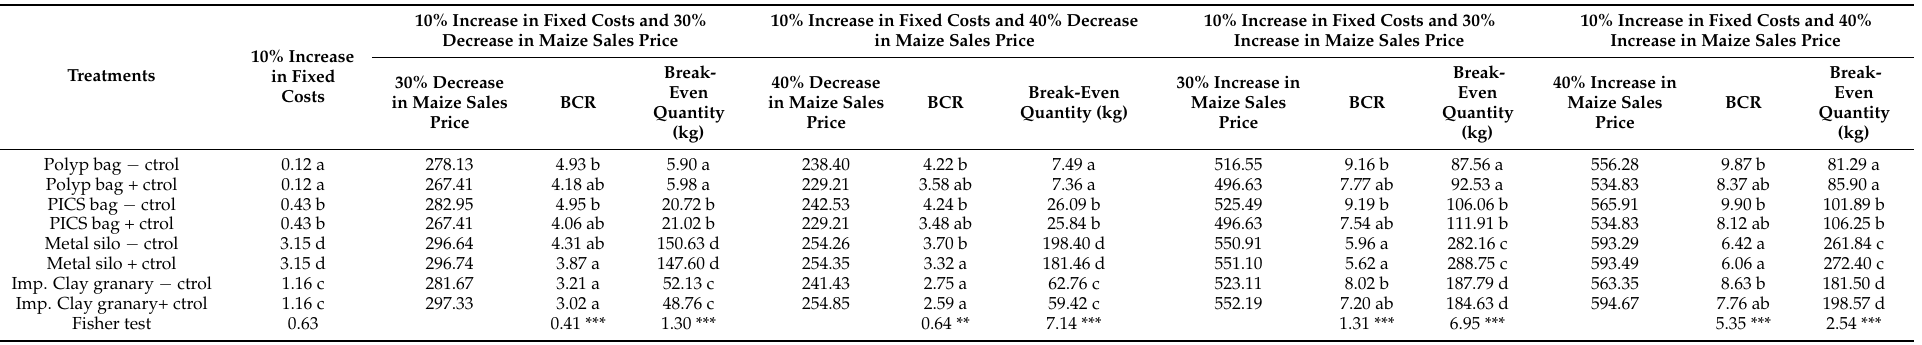
Table 6. Sensitivity analysis of the benefit–cost ratio and the break-even quantity of the different treatments implemented in Boukoumb é